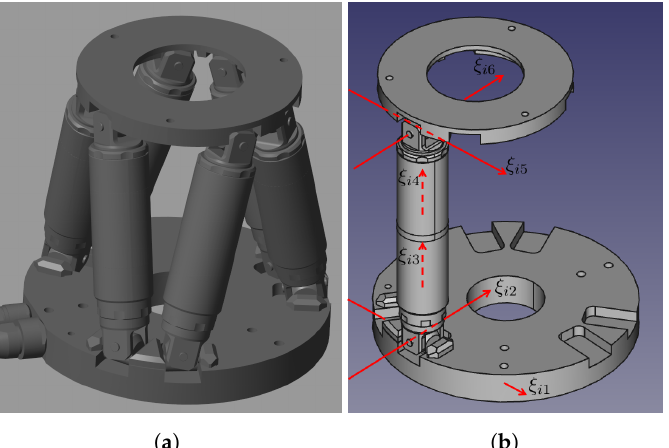
Figure 3. The Stewart platform: ( a ) the CAD model; ( b ) twist definitions and initial pose of the i -th chain.